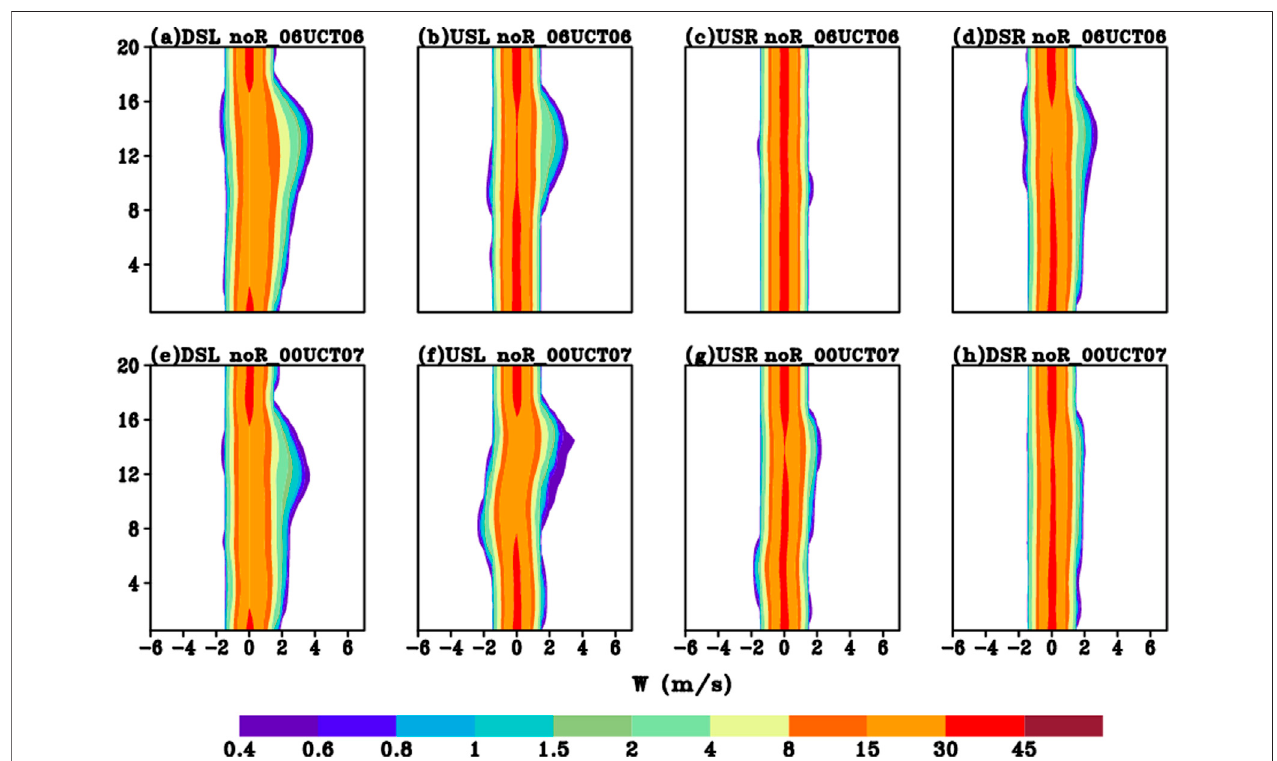
FIGURE 6 | As in Figure 5 , but in